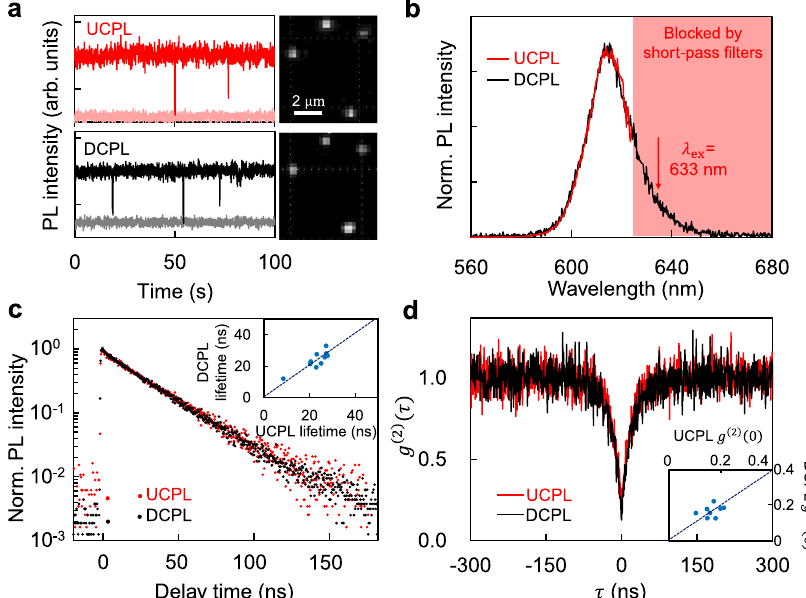
Fig. 3 UCPL and DCPL properties of single QDs. a UCPL and DCPL microscopic images of 4 single QDs (right) and representative intensity time trajectories of a single QD with backgrounds in light colours (left). b Normalized UCPL and DCPL spectra of a typical single QD. c Normalized decay dynamics for UCPL and DCPL of a typical single QD. Inset: correlation of UCPL and DCPL decay lifetimes of 11 single QDs. d Second-order correlation functions ( g 2 ð Þ ð τ Þ ) of a typical single QD under up-conversion and down-conversion excitations. Inset: correlation of UCPL and DCPL g 2 ð Þ ð 0 Þ of 11 single QDs. Dashed lines in the insets indicate equal values on x and y axes. The excitation wavelengths for UCPL and DCPL measurements are 633 and 405 nm,